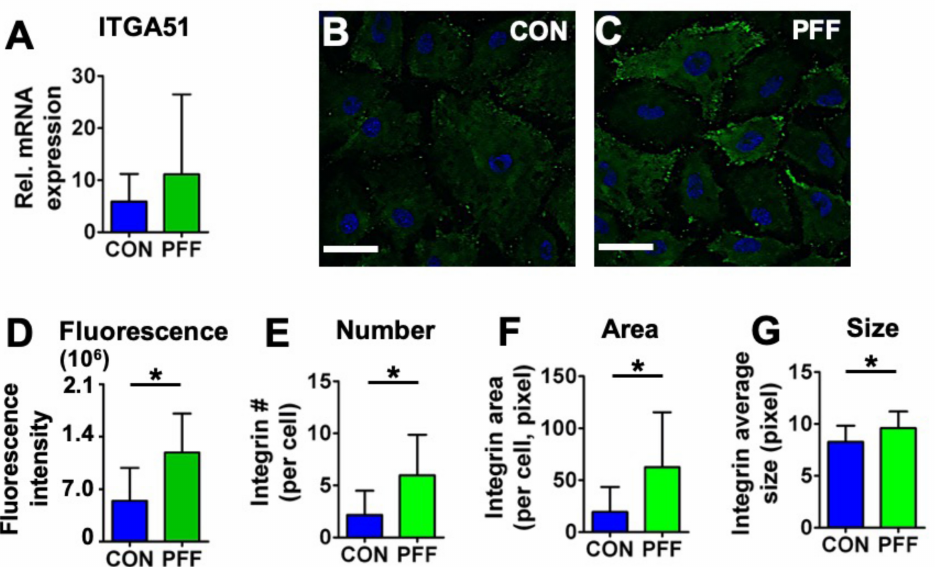
Figure 5. E ff ect of 1 h PFF on integrin- α 5 expression and distribution in MC3T3-E1 osteoblasts. ( A ) mRNA expression of ITGA51 . ( B ) 2D images of control cells stained for integrin- α 5 (green) and DAPI for the nucleus (blue). ( C ) 2D images of 1 h PFF-treated cells stained for integrin- α 5 (green) and nucleus (blue). Bar = 50 µ m. ( D ) Fluorescence intensity of integrin- α 5 in control and PFF-treated cells. ( E ) Integrin- α 5 number in control and PFF-treated cells. ( F ) Integrin- α 5 area in control and PFF-treated cells. ( G ) The integrin- α 5 average size in control and PFF-treated cells. * p < 0.05. CON, control; PFF, pulsating fluid flow.